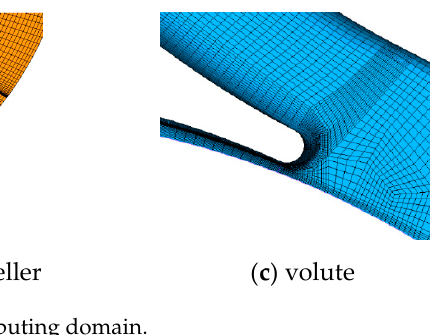
Figure 3. Assembly diagram of the calculation domain.